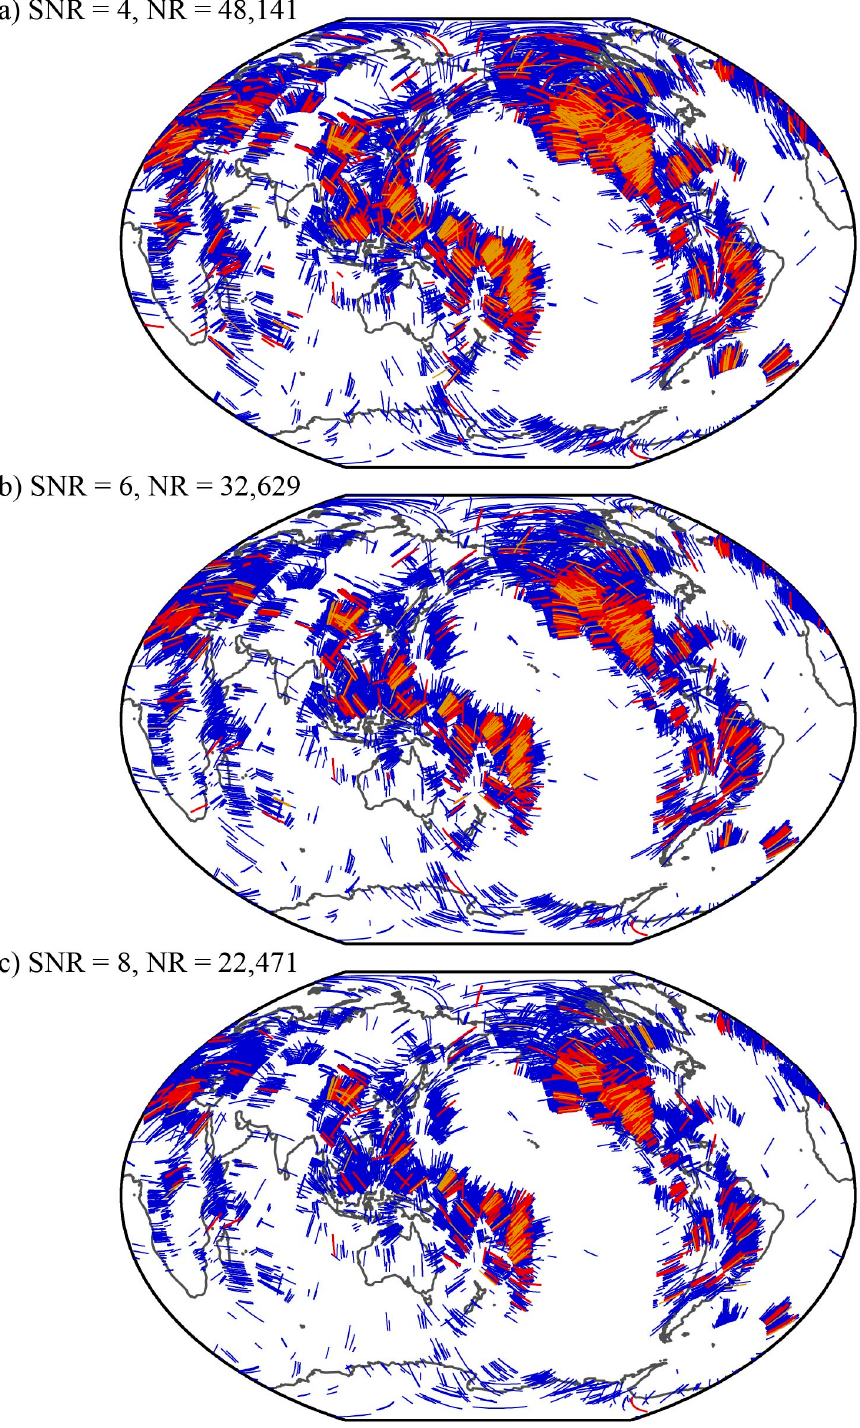
Figure 7. Locations of anomalous waveforms. The Pd segments of SPdKS and SKPdS are drawn for data analyzed in this study. Blue Pd segments indicate no anomaly was detected, orange Pd segments indicate an anomaly was detected above 98% of the noise, and red Pd segments indicate an anomaly was detected above 100% of the noise. Each panel corresponds to a minimum signal-to-noise (SNR) ratio of data. ( a ) SNR minimum = 4, with a total of 48,141 waveforms examined. Similarly, ( b ) SNR minimum = 6 and 32,629 waveforms, and ( c ) SNR minimum = 8 and 22,471 waveforms.